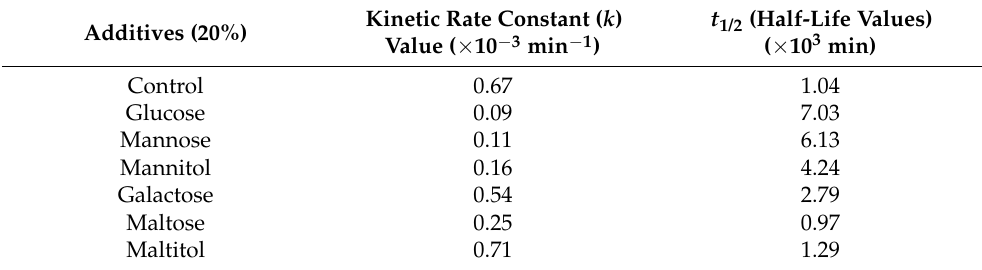
Table 2. The kinetic rate constant and half-life values of C-PC with 20% additives under 4.5% H 2 O 2 oxidative